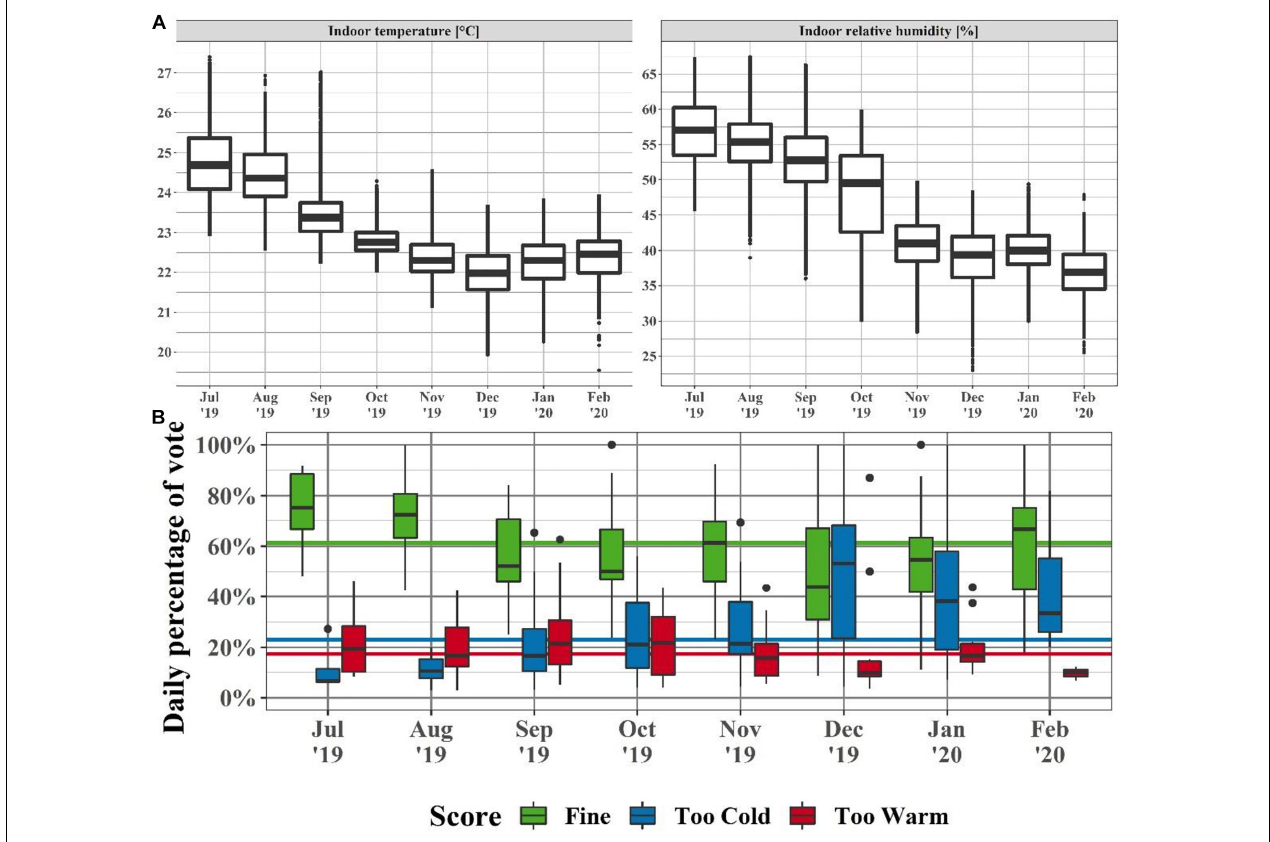
FIGURE 12 | Case II. (A) Boxplot of indoor temperature and relative humidity during occupied hours. (B) Daily percentage of votes cast with TiAQ. Horizontal lines show the overall median of each vote type. “Ill-willed” votes were